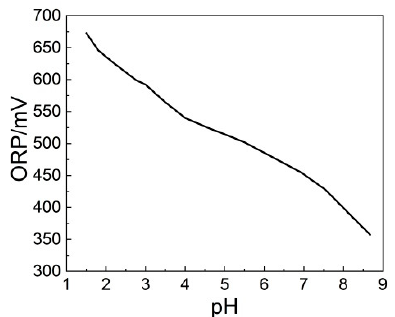
Figure 4. Effect of the pH of the NaClO 2 solution on ORP value. Experimental conditions: NaClO 2 concentration 0.01 mol/L; temperature 30 °C.